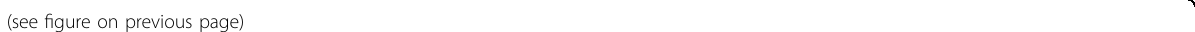
Fig. 6 Tumor-secreted PLAU promoted the formation of in fl ammatory CAFs, which secreted IL8 via phosphorylation of Akt/NF- κ B. A Transcriptional pro fi le of NFs and CAFs with or without recombinant PLAU treatment. B Recombinant PLAU promoted activation of cytokine, chemokine, and interleukins pathways and NF- κ B canonical pathways as demonstrated by GSEA. C RT-qPCR detection of markers of iCAFs and myCAFs in CAFs with or without recombinant PLAU treatment. D A 48-cytokine panel was used to characterize the CM of CAFs with or without recombinant PLAU treatment. E , F Detection of IL8 expression in CM of CAFs with or without recombinant PLAU treatment in the presence or absence of IPR-803, a uPA-uPAR inhibitor, by ELISA ( E ) and western blot ( F ). G – J Experimental scheme ( G ) and detection of IL8 expression in CM of indicated CAFs cocultured with PLAU overexpressing and vector KYSE-450 cells ( H , J ) or treated with CM of PLAU overexpressing and vector KYSE-450 cells ( I , J ), in the presence or absence of IPR-803 as assessed by ELISA ( H – I ) and western blot ( J ). The CM used for western blots was concentrated 40- fold. K Top 20 predicted transcription factors of CXCL1 predicted by the Cistome website. L Detection expression of uPAR, total and phosphorylated Akt and p65 of indicated CAFs. Three biological replicates were performed for in vitro assays. Data in bar charts are presented as the mean ± SD. * P < 0.05, ** P < 0.01, *** P < 0.001, **** P < 0.0001 (Student ’ s t